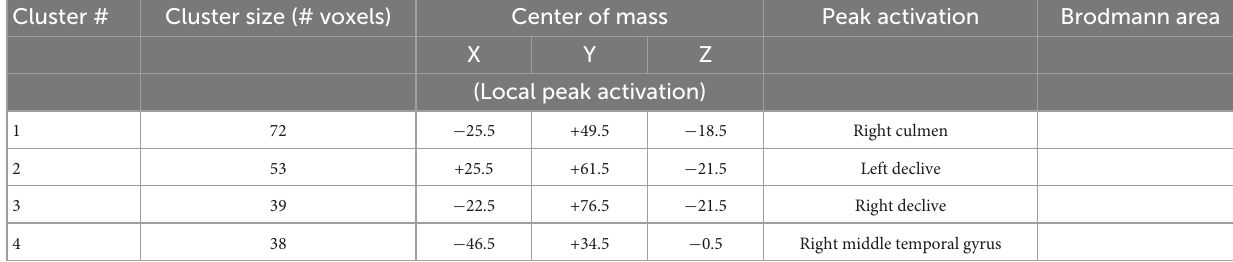
TABLE 3 Regions with significant emotion